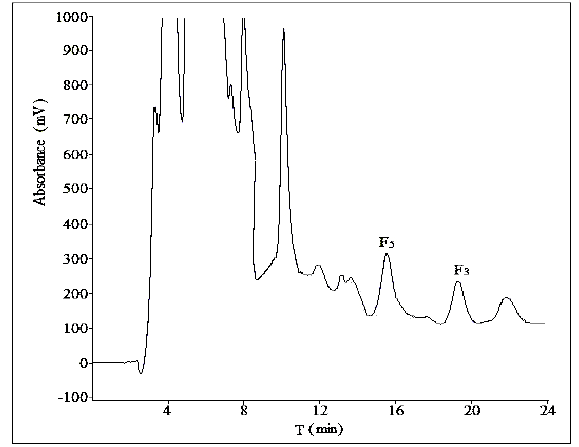
Figure 6. The semi-preparative chromatogram of CEFBPG with the mobile phase of acetonitrile:water (28:72) at room temperature and a flow rate of 15 mL/min.